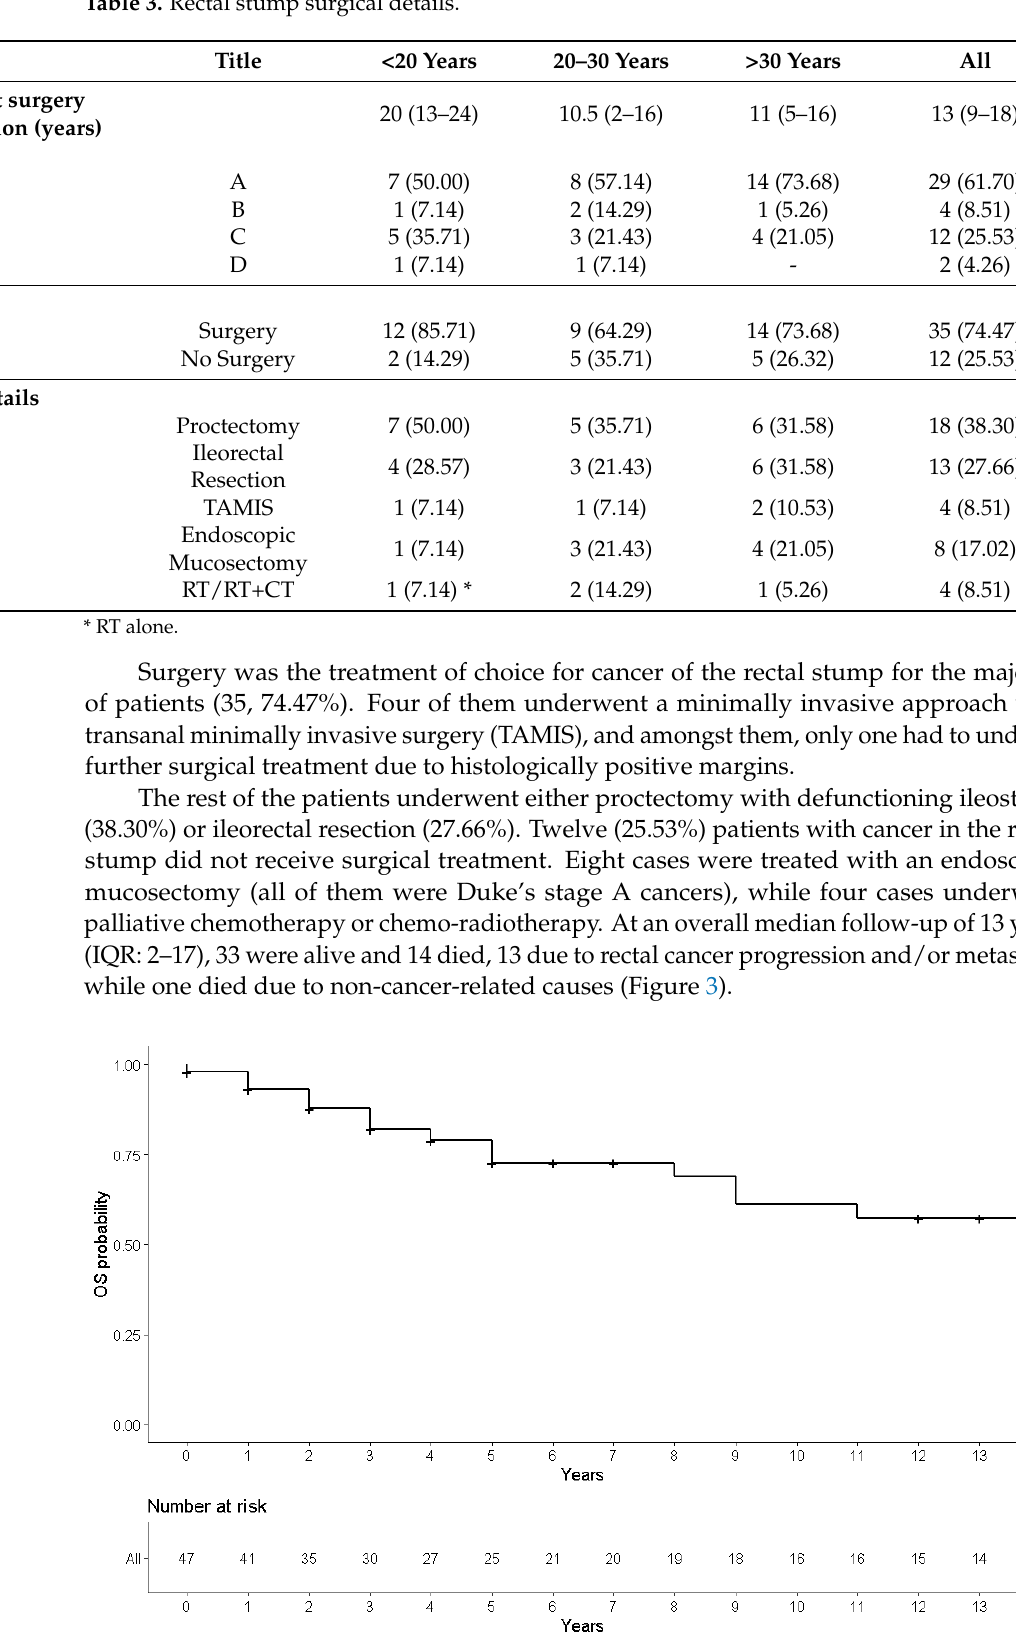
Table 3. Rectal stump surgical details.